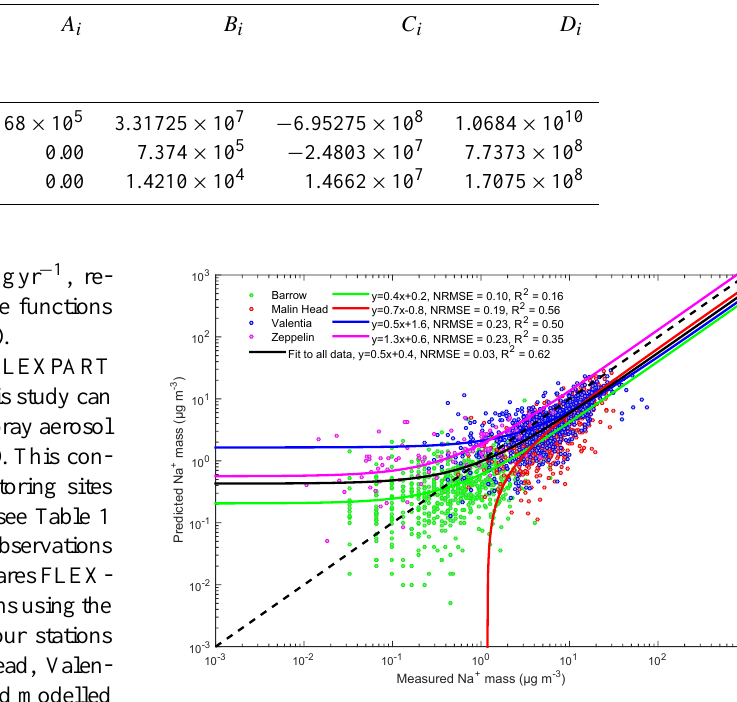
Figure 6. Comparison of FLEXPART modelled with measured Na + concentrations using the sea spray source function presented here for four stations included in the comparison by Grythe et al. (2014). Linear orthogonal fits are shown along with the correlation coefficient for the whole data set as well the individual stations. Compared to standard linear least-squares regression, which min- imises the error only in the y direction, the orthogonal fitting proce- dure used minimises the error in both the x and y directions. Also presented are the normalised root mean square errors (NRMSE) for the whole data set as well as the individual stations. Here the NRMSE is the root mean square error normalised to the difference between the maximum and minimum measured values for the entire data set or individual